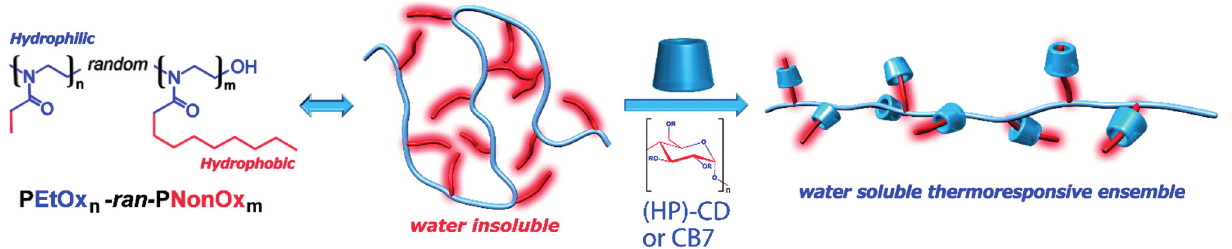
Figure 1. A series of amphiphilic PEtOx- ran -PNonOx random copolymers was